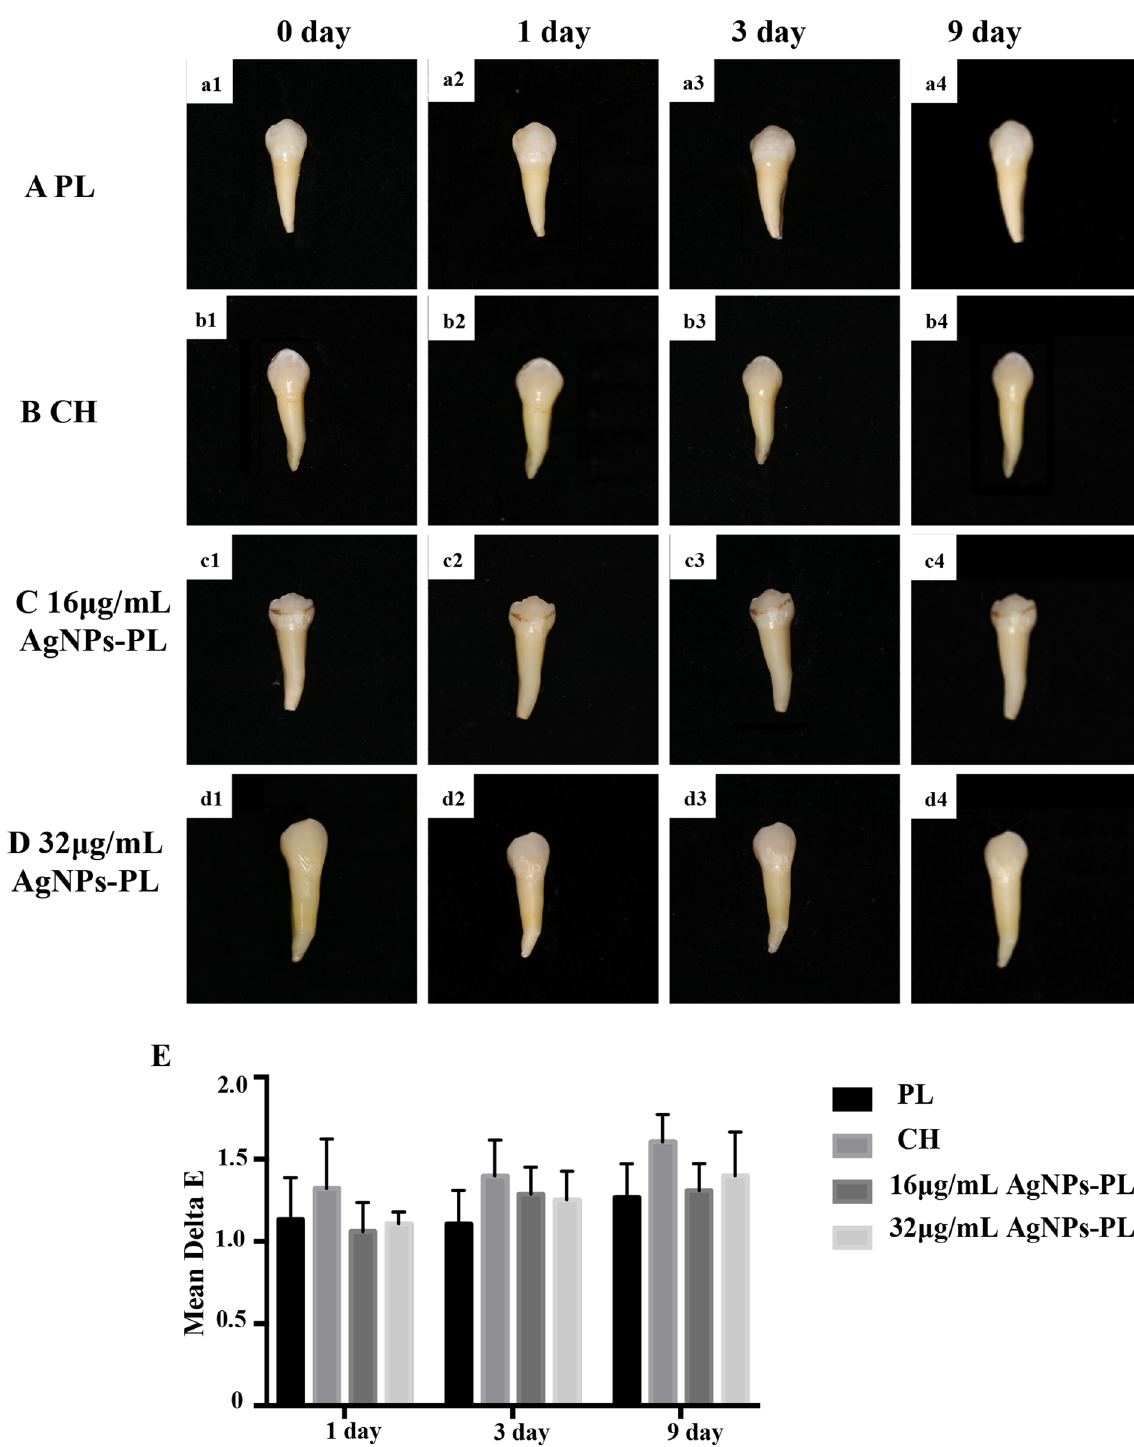
Figure 10. Photographic images of the 0, 1, 3, and 9 days measurements. ( a1 – a4 ) PL group; ( b1 – b4 ) CH group; ( c1 – c4 ) 16 μg/mL AgNPs-PL group; ( d1 – d4 ) 32 μg/mL AgNPs-PL; e. ∆E* value after treatment with different medicaments for 0, 1, 3, and 9